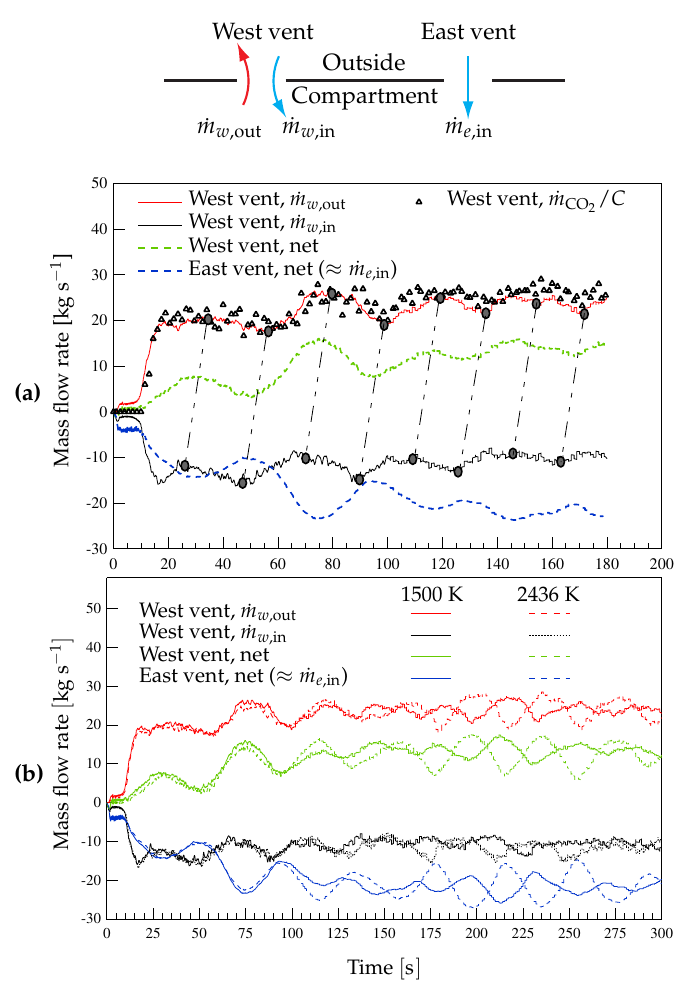
Figure 5. (a) Mass flow rates through the west and east vents obtained with FDS for Case G-4 ( T in = 1500 K). Triangle symbols: CO 2 mass flow rate through the west vent divided by C = 7 (b) Comparison between FDS results for the mass flow rates through the west and east vents for cases G-1 and G-4 ( T in = 2436 and 1500 K).